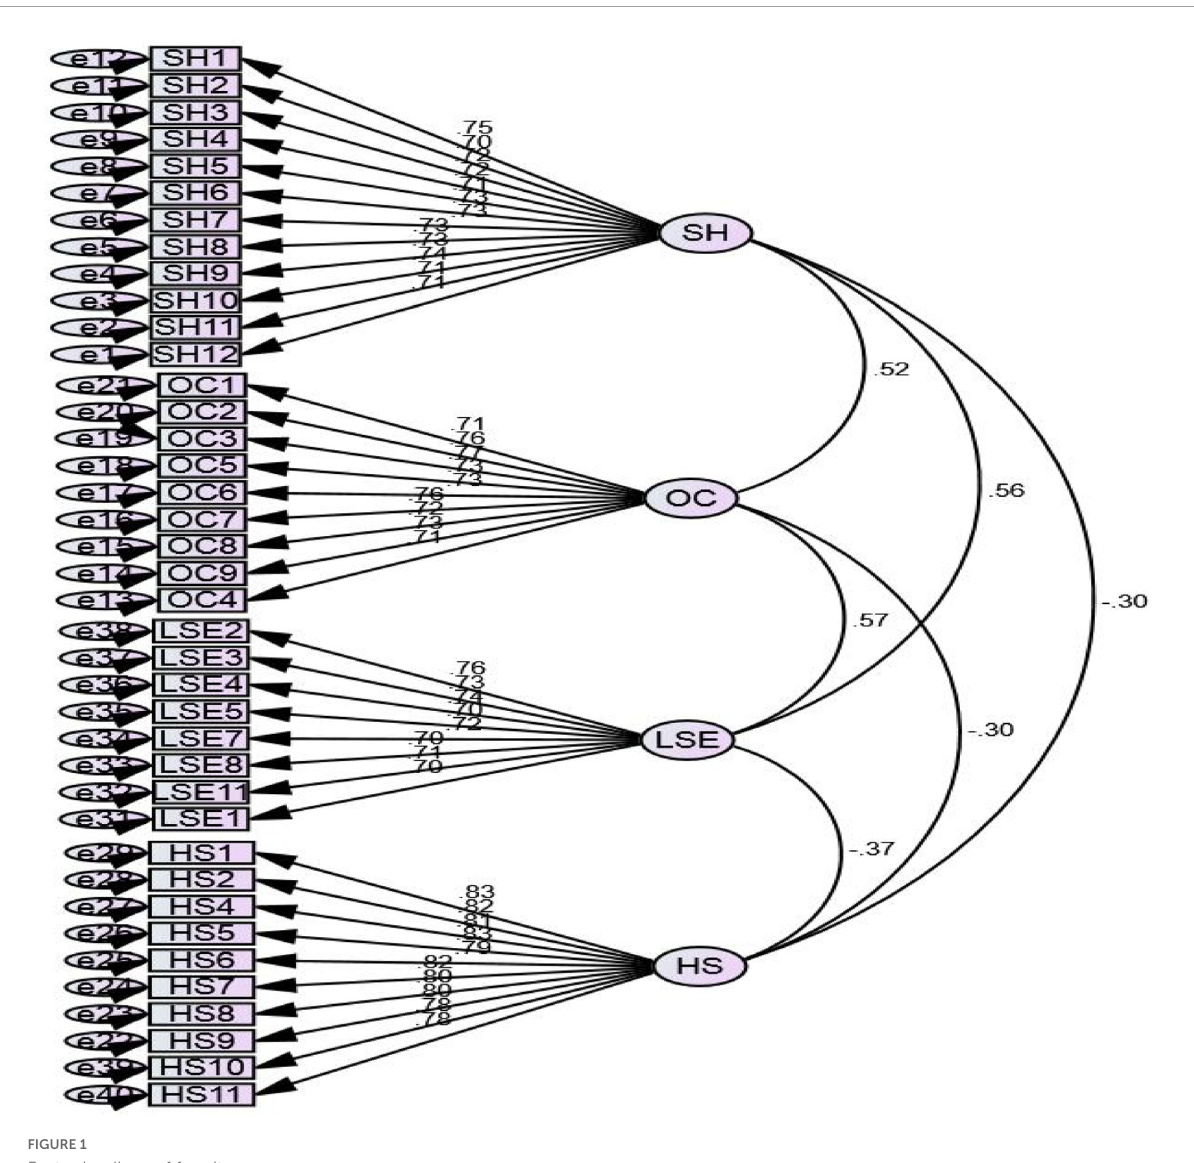
FIGURE1 Factor loadings of four items.